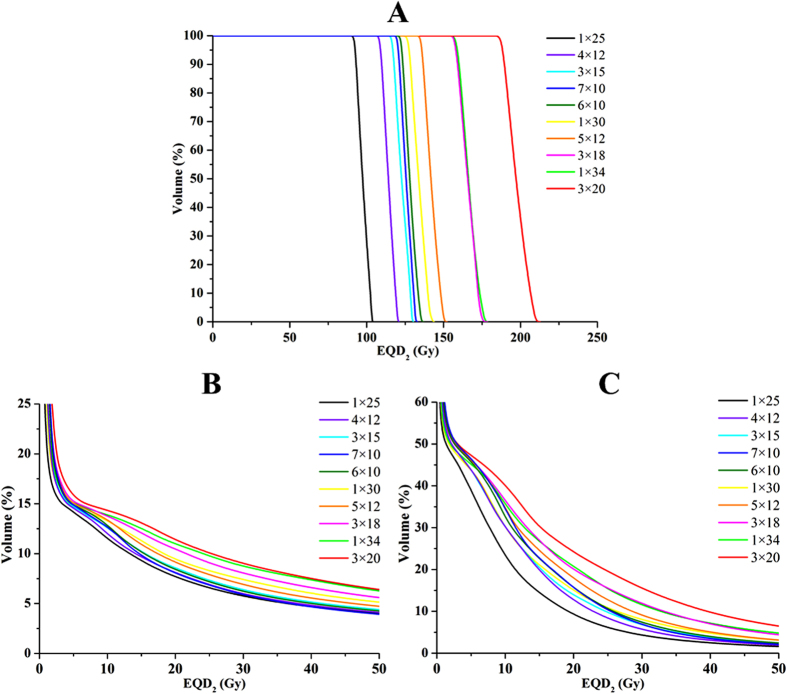
cDVH of the GTV, lung and CW in ten fraction regimens after EQD2 conversion.(A) cDVH of the GTV. (B) cDVH of the lung. (C) cDVH of the CW.